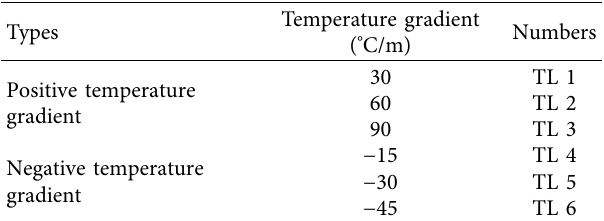
Figure 13: Experimental and the calculated results of the temperature load test (40 ° C). Table 7: Temperature gradient load calculation